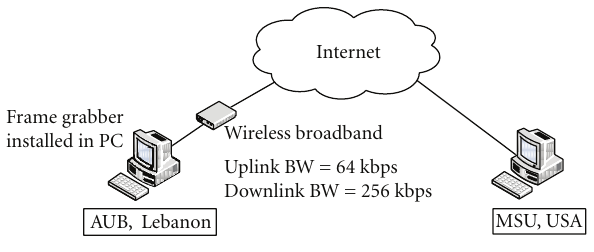
Figure 7: Remote test setup.